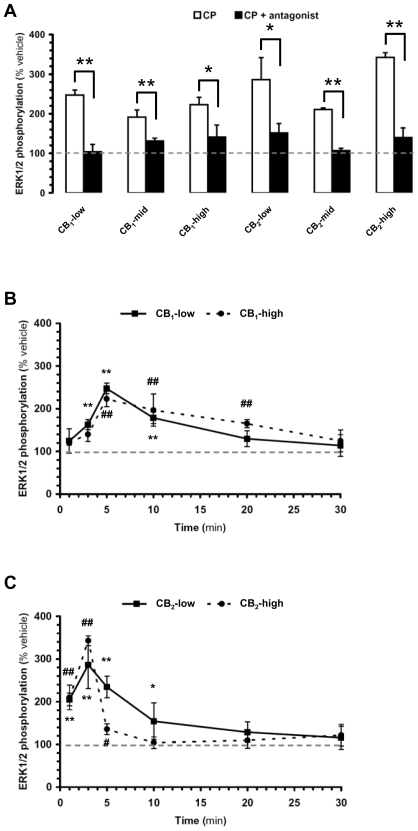
Activation of CB1 and CB2 receptors increases ERK1/2 phosphorylation in all DBT subclones.DBT subclones stably expressing cannabinoid receptors were expanded in 24-well plates, incubated with CP-55,940 (CP, 1 µM), and ERK1/2 phosphorylation quantified by Western blot analysis. (a) CB1- and CB2-expressing subclones were incubated with CP for 5 and 3 min, respectively (white bars). When testing the effect of antagonists, cells were pretreated with SR141716A (5 µM) and SR144528 (3 µM) added 10 min before CP (black bars). (b,c) Kinetics of CP-induced increase in ERK1/2 phosphorylation in CB1-low, CB1-high, CB2-low and CB2-high subclones. Data = mean±s.e.m. of 6–8 independent experiments expressed as % of vehicle (i.e. level of ERK1/2 phosphorylation when treated with vehicle, i.e. 0.1% DMSO. Note that basal ERK1/2 phosphorylation did not vary significantly over time (Figure S1a). In (a), (*) = p<0.05 and (**) = p<0.01 significantly different from the response in the presence of inhibitor, ANOVA followed by Bonferroni's post-test. In (b,c), (*) and (#) = p<0.05, and (**) and (##) = p<0.01 significantly different from vehicle at corresponding time point, ANOVA followed by Bonferroni's post-test.